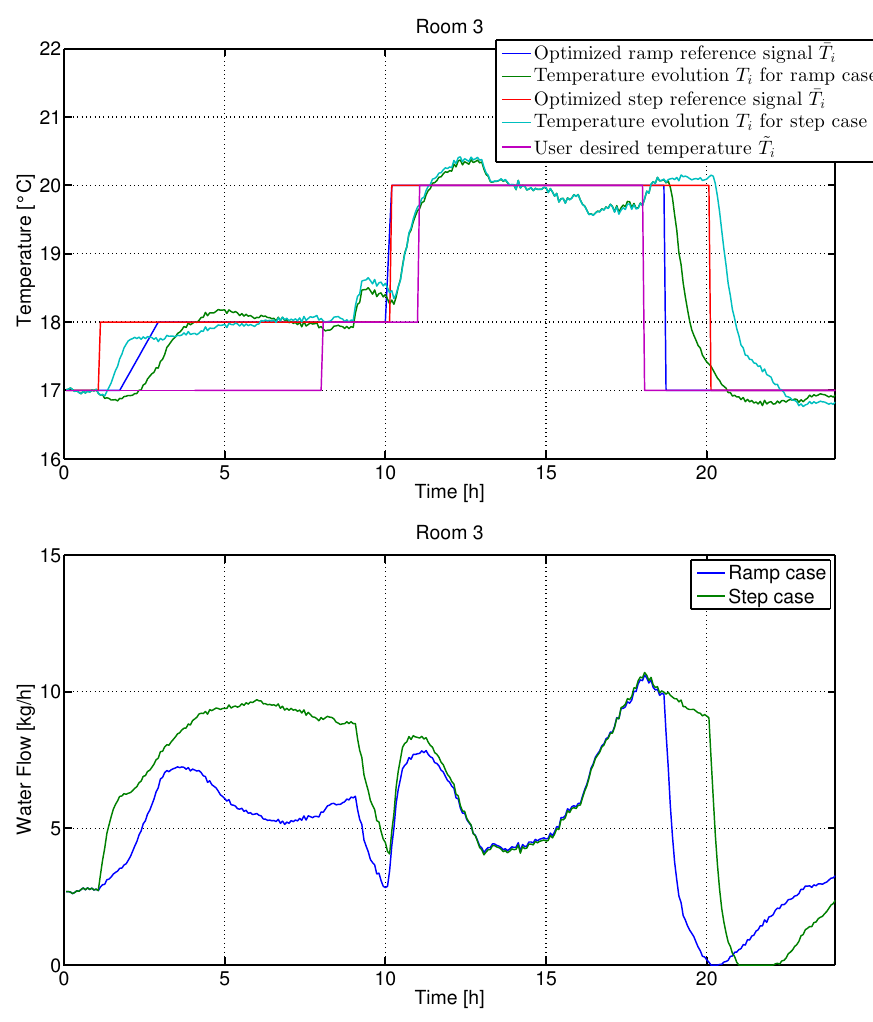
Figure 6. Results obtained by simulating the ARMAX model of room 3 with radiators for one day, 5